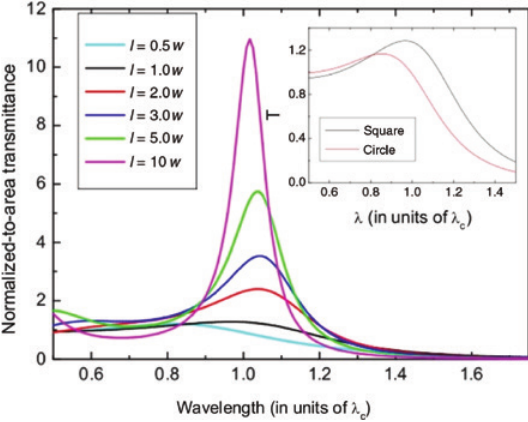
Figure 14: Normalize-to-area light transmission through single rectangular slot in perfect electric conductor plate, implying that the total transmission is almost independent of the width w . = 2 l is the resonance condition. This figure is reproduced Here, λ c from Ref.